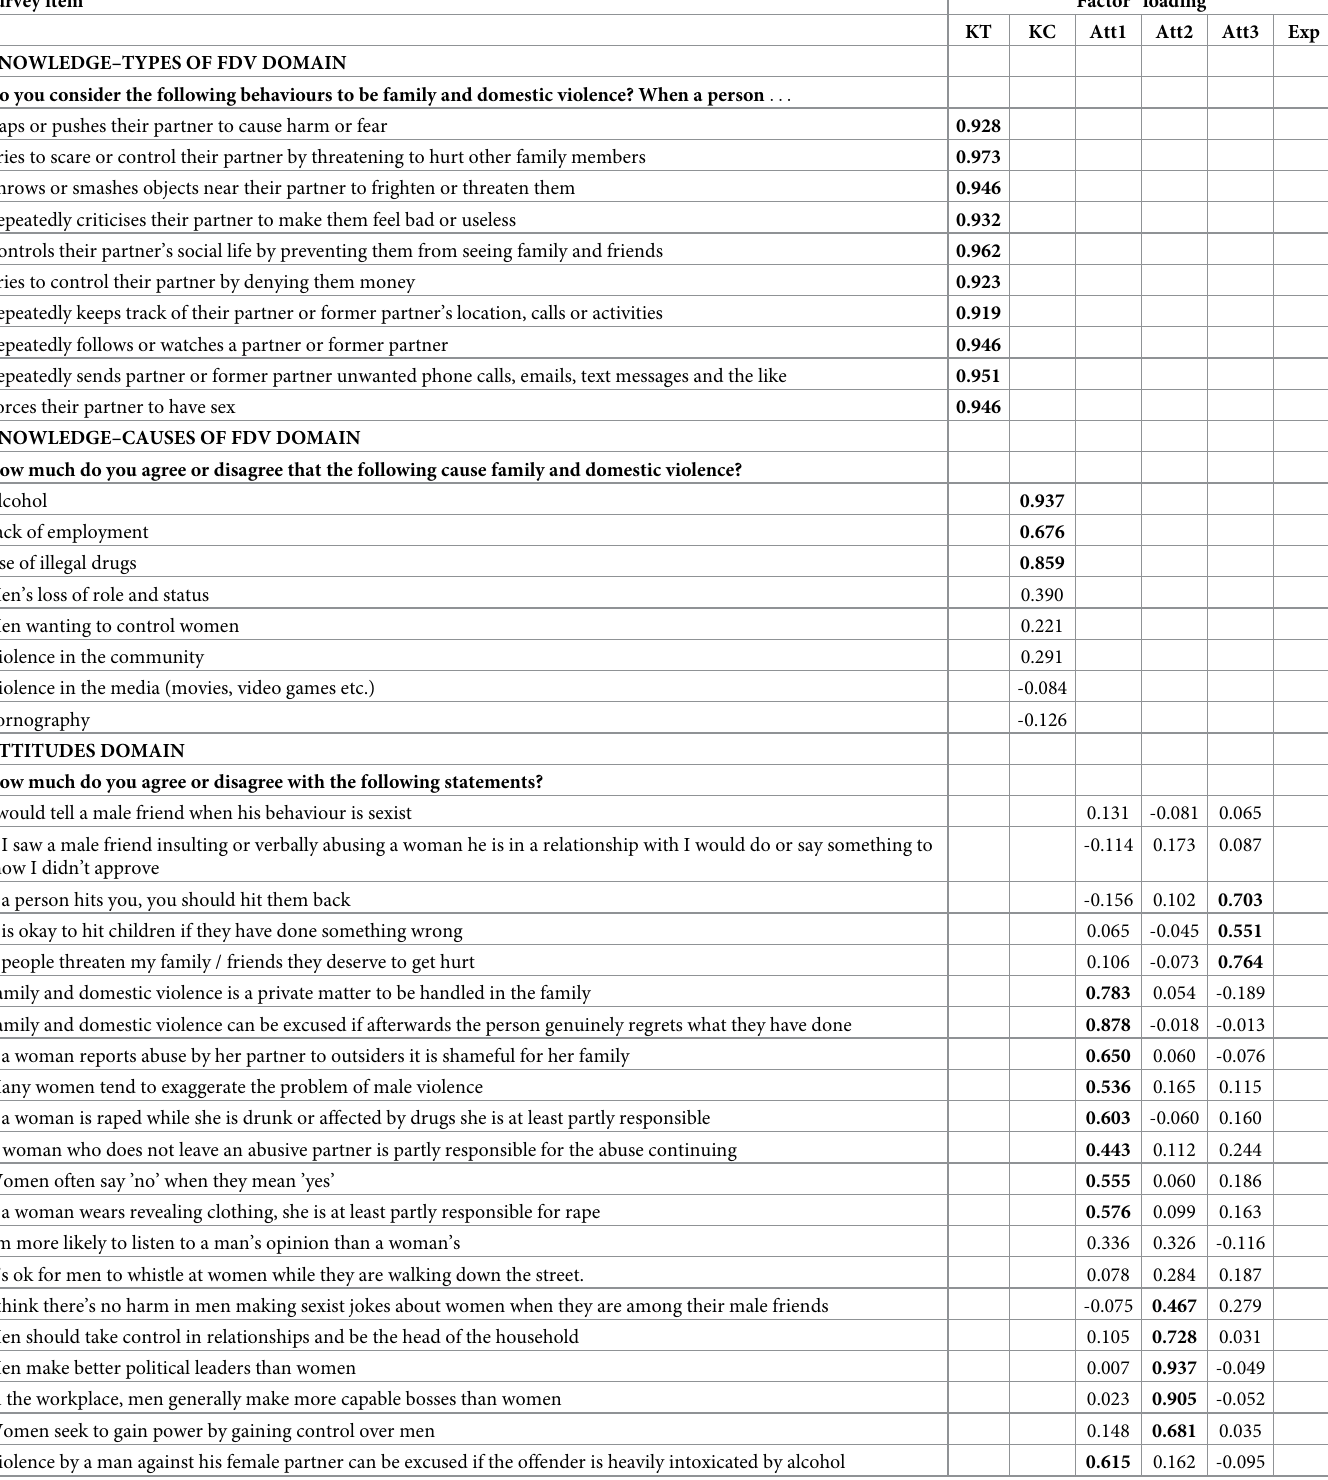
Table 2. Exploratory factor analyses a